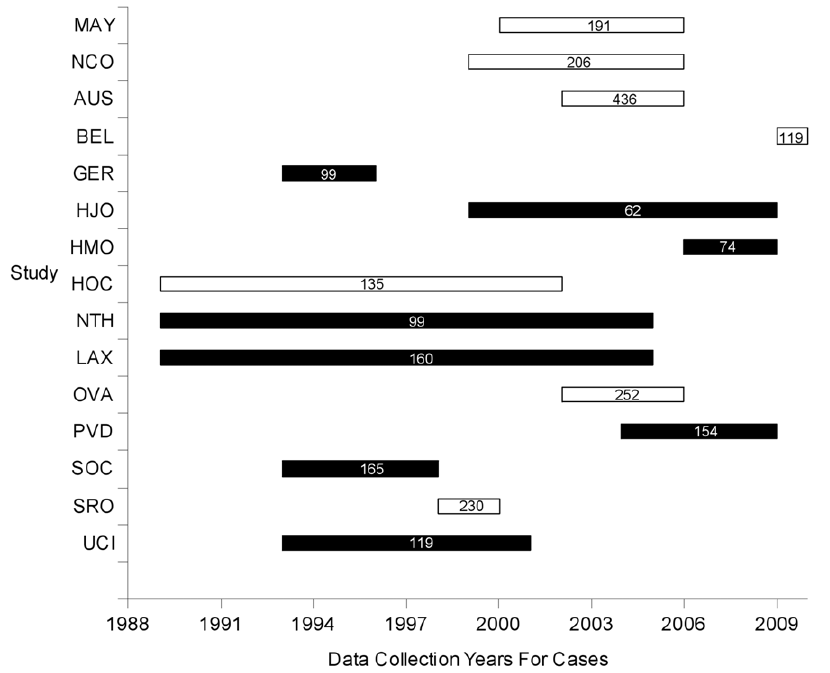
Figure 3. Recruitment years for cases in each study. White bars denote studies showing no association or inverse associations between DCN or LUM SNPs with serous epithelial ovarian cancer, whereas black bars denote studies showing positive associations. Numbers in bars represent number of cases used in analyses.